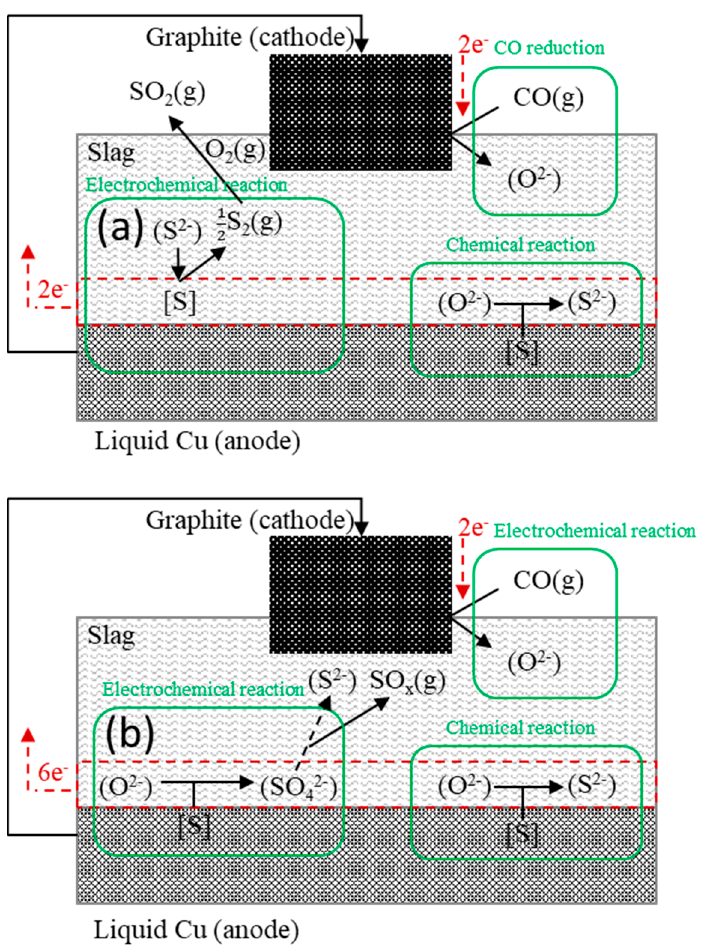
Figure 7. Proposed anodic electro-desulfurization mechanism in the CSA slag. ( a ) anodic sulfur evaporation ( b ) anodic desulfurization.